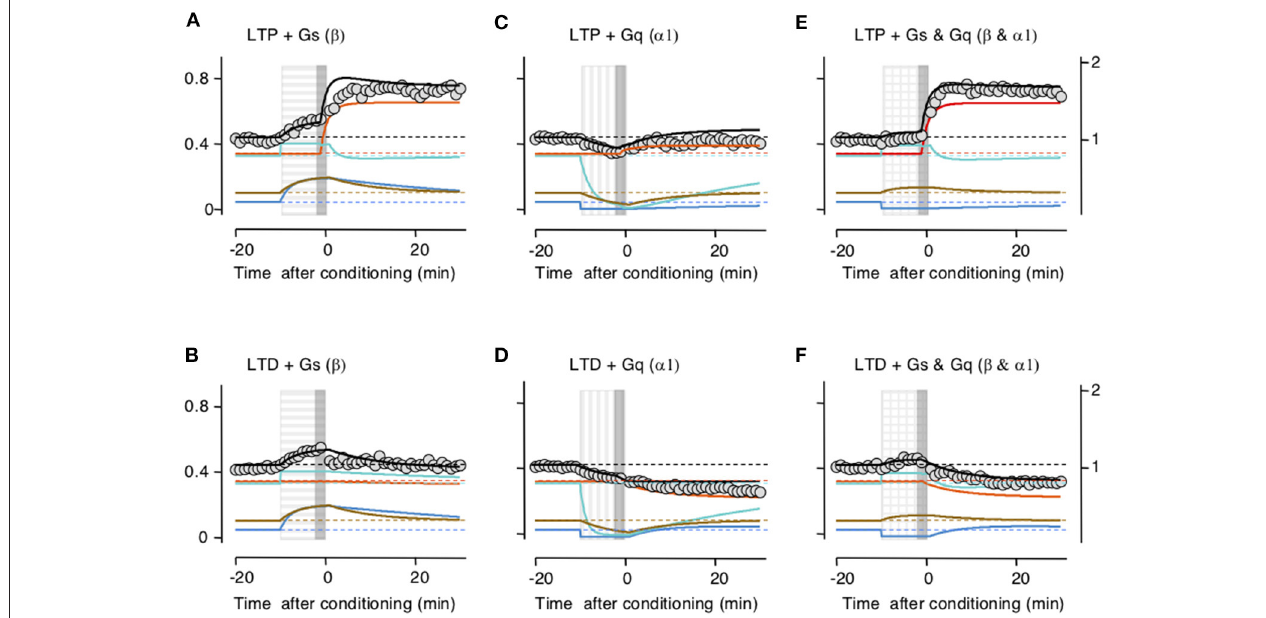
FIGURE 3 | Simulation of how Gs- and Gq-coupled receptors affect the induction of long-term potentiation (LTP) and long-term depression (LTD) by filling and depleting AMPA receptor synaptic compartments. The upper row shows the effects on LTP; the lower row, the effect on LTD. Color conventions of compartments as in Figure 2 . PeriIN: green; PeriOut: blue; Non-anchored: brown; postsynaptic density compartment: red; Synaptic conductance: black; actual data from Huang et al. (2012): gray circles. Left column (A,B) shows that Gs-GPCR stimulation (horizontally striped bar) fills up the PeriIN and PeriOut compartments, barely affecting the induction (gray vertical bar) of LTP (A) , but preventing the induction of LTD (B) . The middle column (C,D) shows that Gq-GPCR stimulation (vertically striped bar) depletes both the PeriIN and the PeriOut compartments, preventing the induction of LTP (C) without affecting the induction of LTD (D) . The right column (E,F)